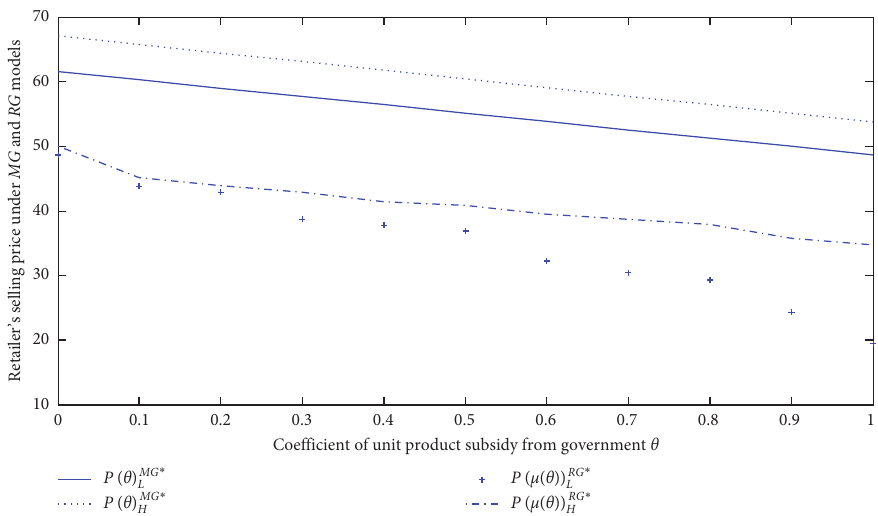
Figure 4: The impact of different government subsidy coefficients on retailer’s selling price under two models.